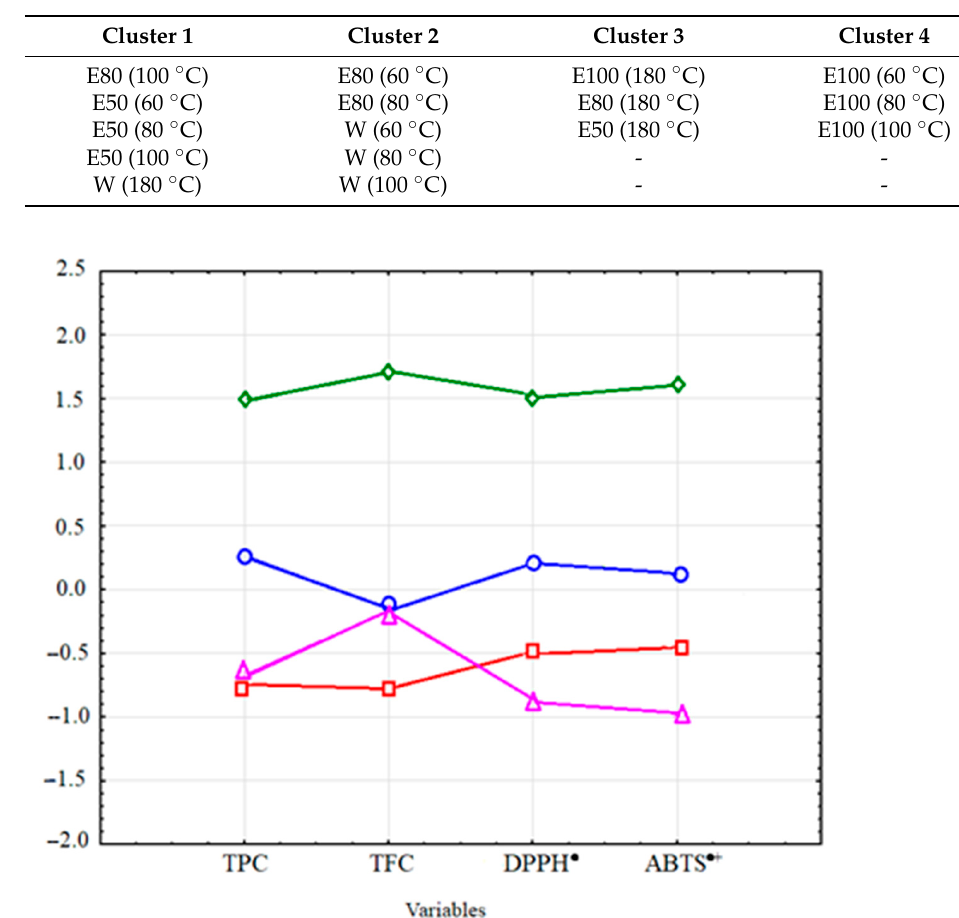
Figure 5. Graph of mean values for four clusters. Abbreviations: Օ —Cluster 1; □ —Cluster 2; ♦ —Cluster 3; ∆ —Cluster 4.